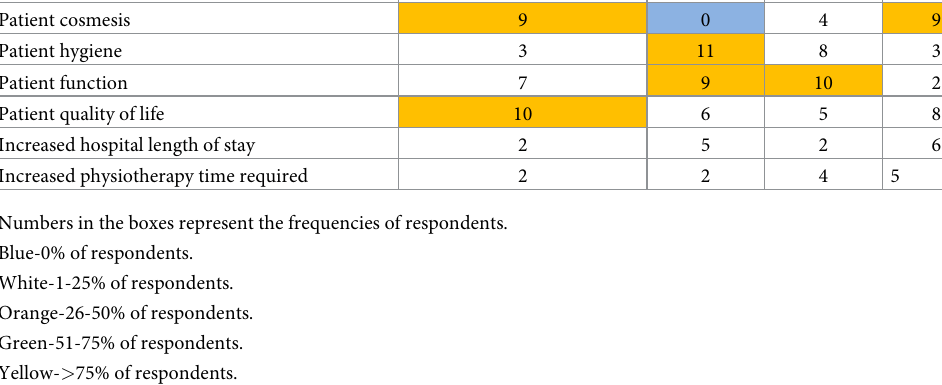
Table 4. Rankings awarded by respondents for the problems that resulted from loss of passive limb range of motion/contracture. Rankings Problems